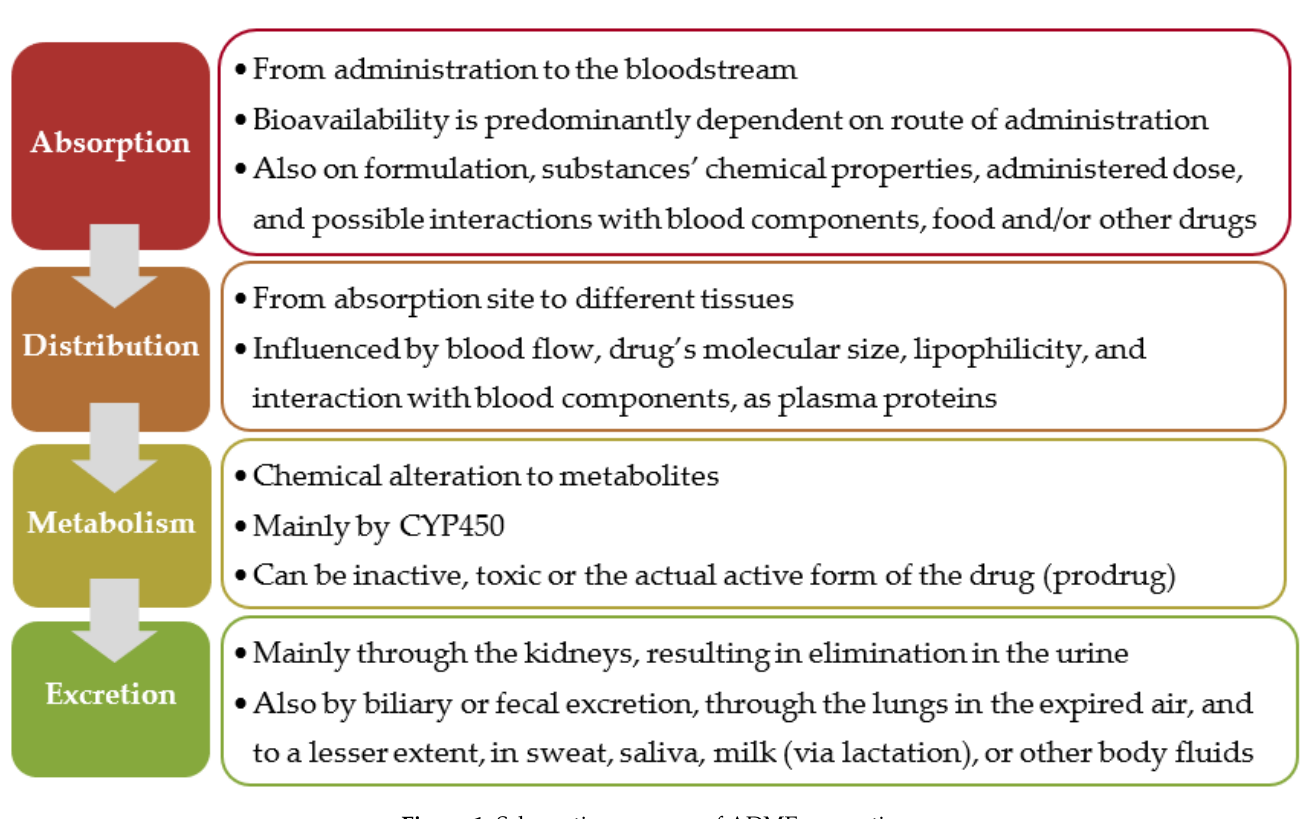
Figure 1. Schematic summary of ADME properties.